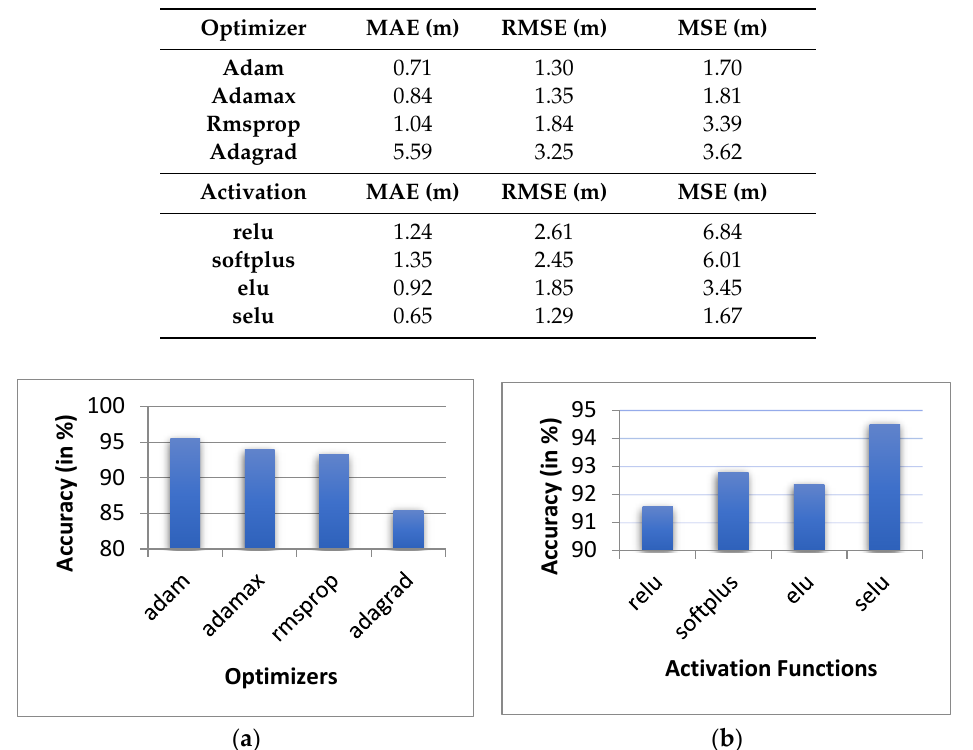
Table 2. Positioning error (in meters (m)) with di ff erent optimizers and activation functions.